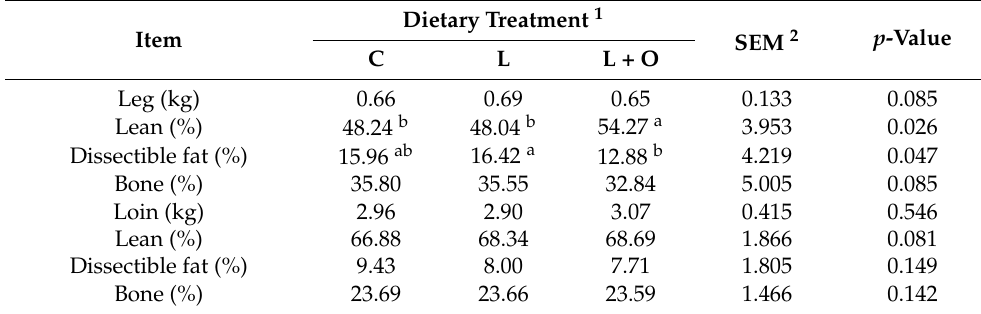
Table 6. Dissection data (% on cut weight) of leg and loin of lambs *.